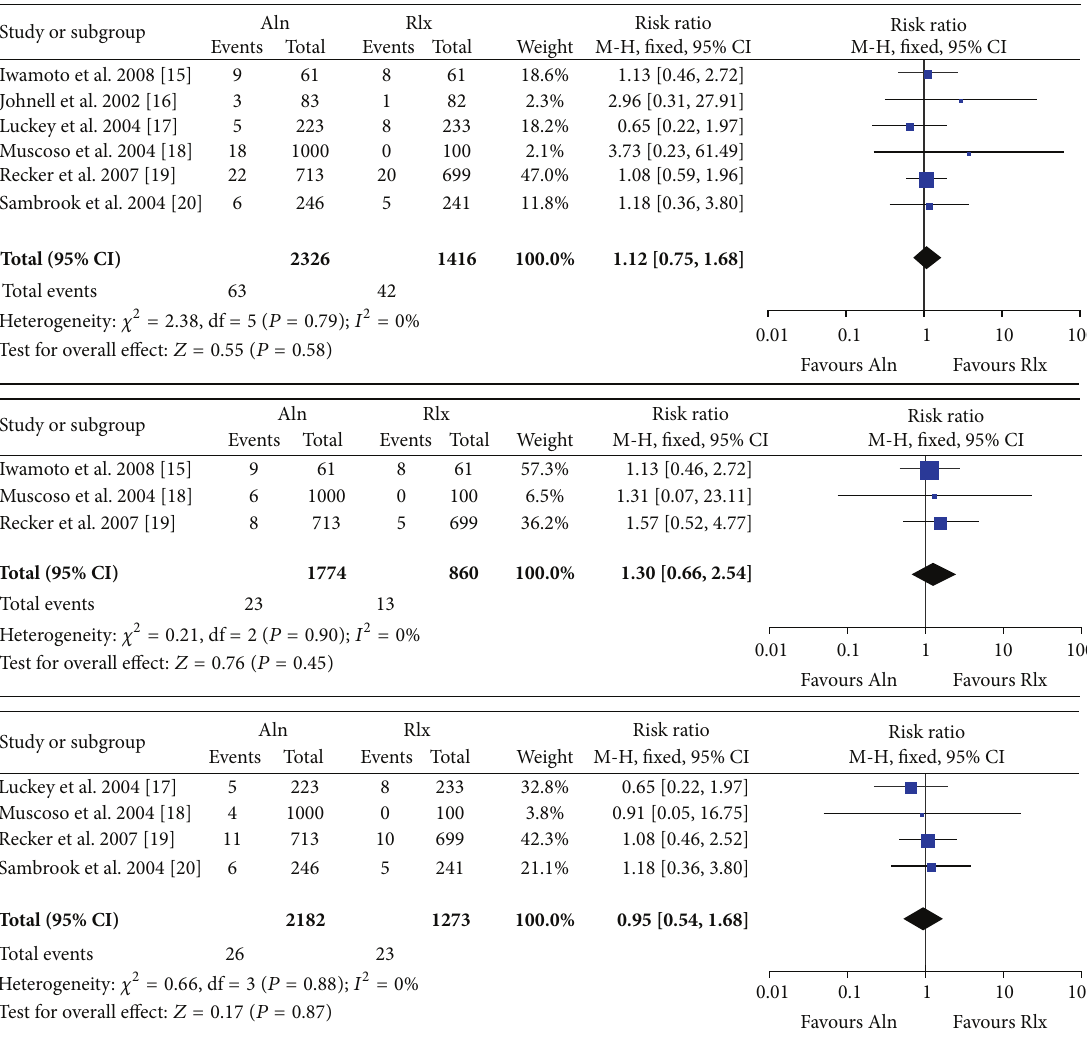
Figure 2: Relative risk of total fractures, vertebral fractures, and nonvertebral fractures for postmenopausal women between the alendronate group and the raloxifene group. NV: